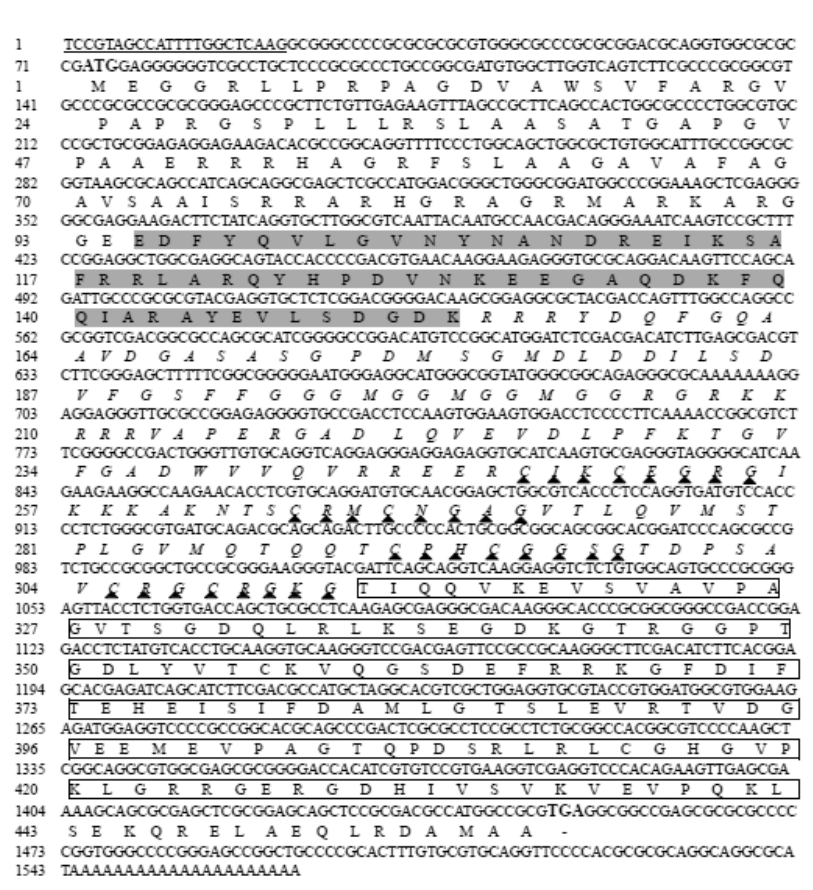
Figure 2. The cDNA and deduced amino acid sequences of StHsp40 (accession number: MN698835): boldface for start and stop codons; underline for DinoSL; dark gray background for the characteristic J-domain (95–153 aa); triangles for the typical 4 repeats of CxxCxGxG in the predicted zinc-finger domain (154–312 aa; italics); box for the putative C-terminal domain (313–442 aa).